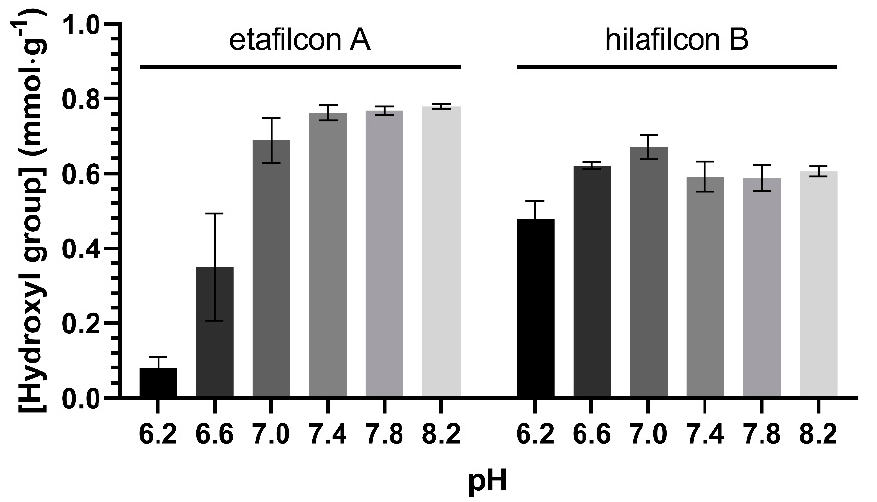
Figure 4. The hydroxyl group content in etafilcon A and hilafilcon B equilibrated in PBS solution (pH 6.2–8.2).